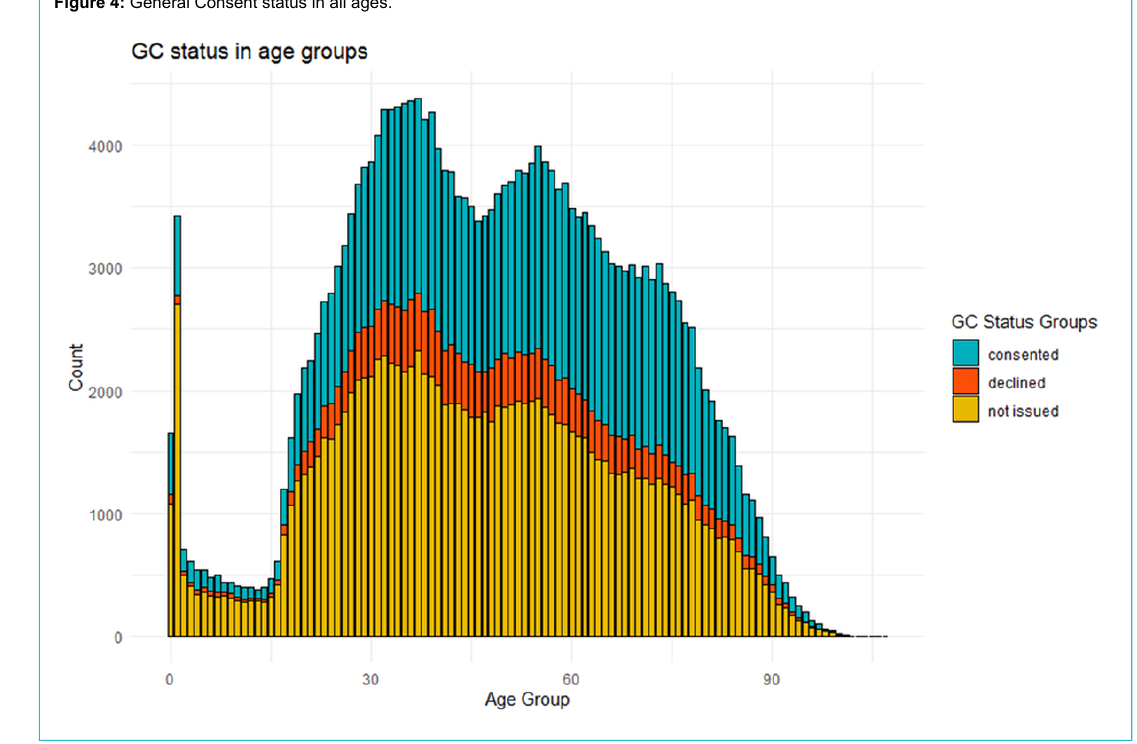
Figure 4: General Consent status in all